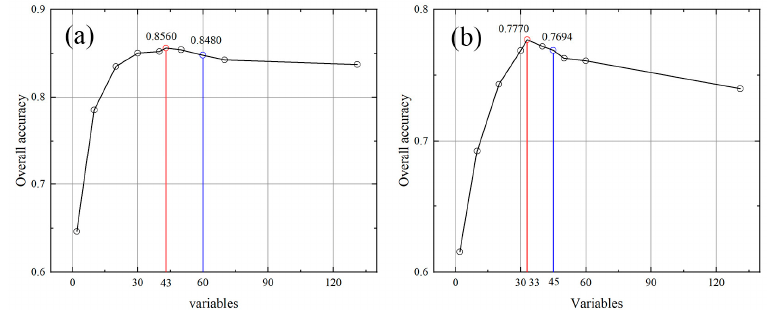
Figure 9. Change of overall accuracy with increasing number of input variables in Variable Selection Using Random Forests (VSURF)-based variable selection (vertical blue line corresponds to number of variables and overall accuracy in first subset after variable selection, and vertical red line corresponds to number of variables and overall accuracy in second subset after variable selection). ( a ) GF-1 data, ( b ) ZY-3 data. Table 9. Overall accuracy of trained RF model using VSURF-based variable selection. OA: overall accuracy; SD: standard